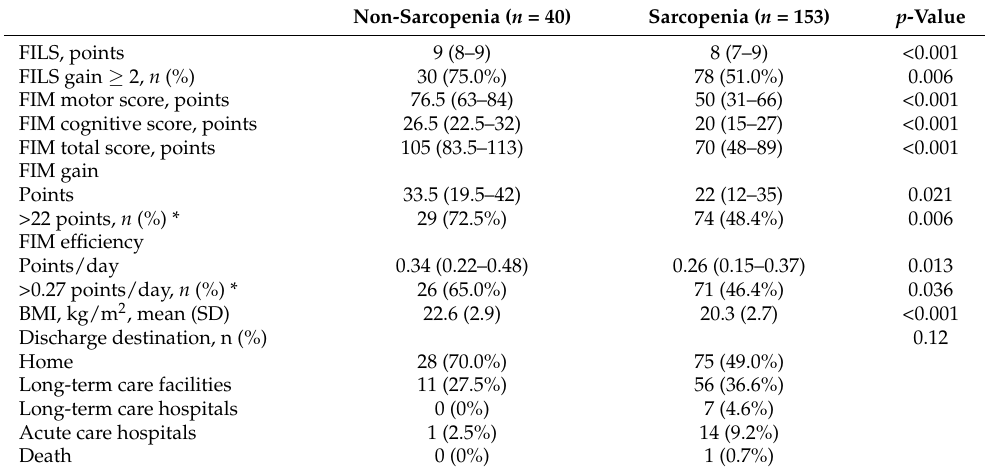
Table 2. FILS and discharge outcomes for 193 stroke rehabilitation patients with